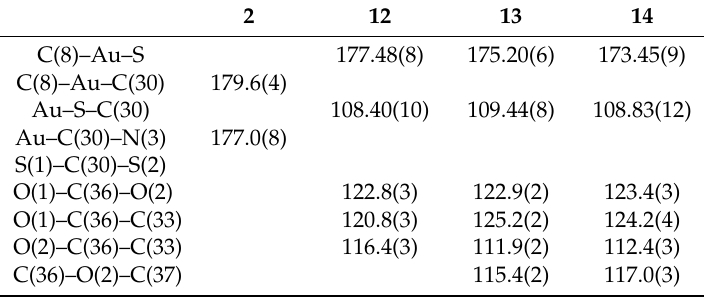
Table 3. Selected bond angles for 2 , 12 , 13 , and 14